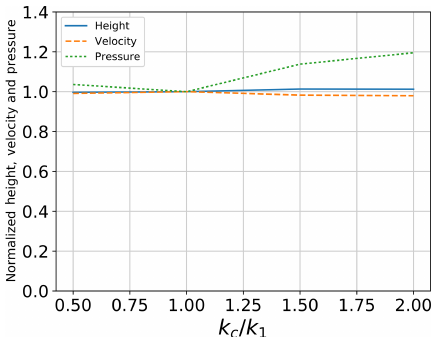
Figure 11. Variation in flow height, velocity and pressure for differ- ent values of the ratio between stiffness parameters ( normalized by results of the simulation with φ b = 30 ◦ , 0 . 3, d 50 = 75mm and α = 30 ◦ .